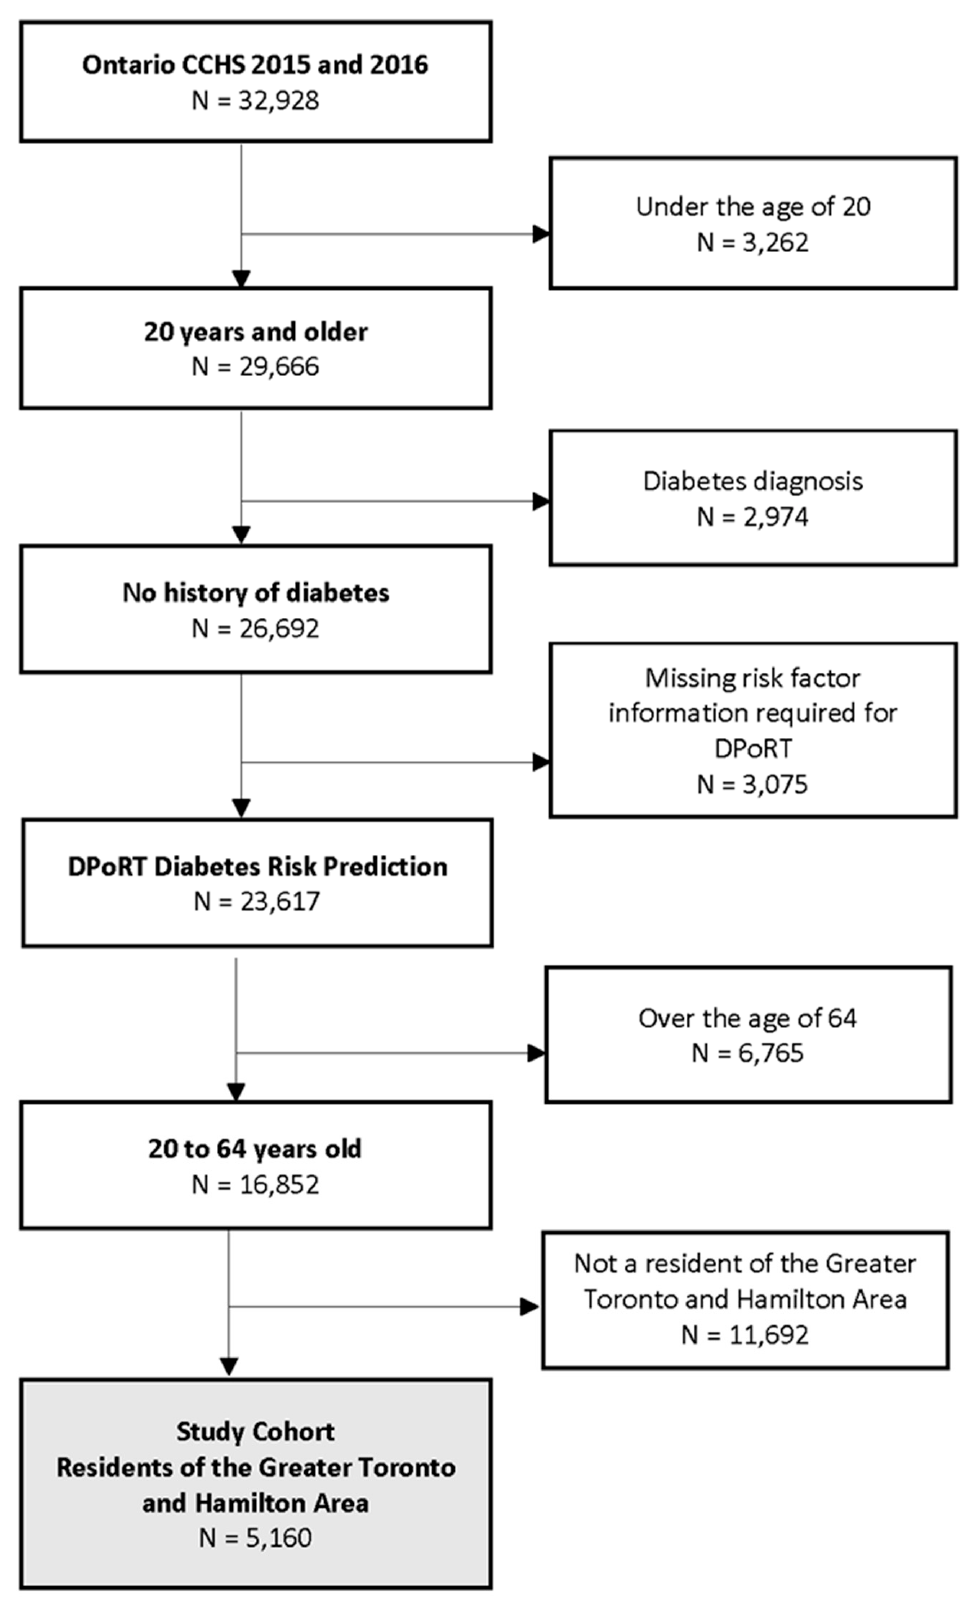
Figure 1. Cohort inclusion and exclusion criteria.